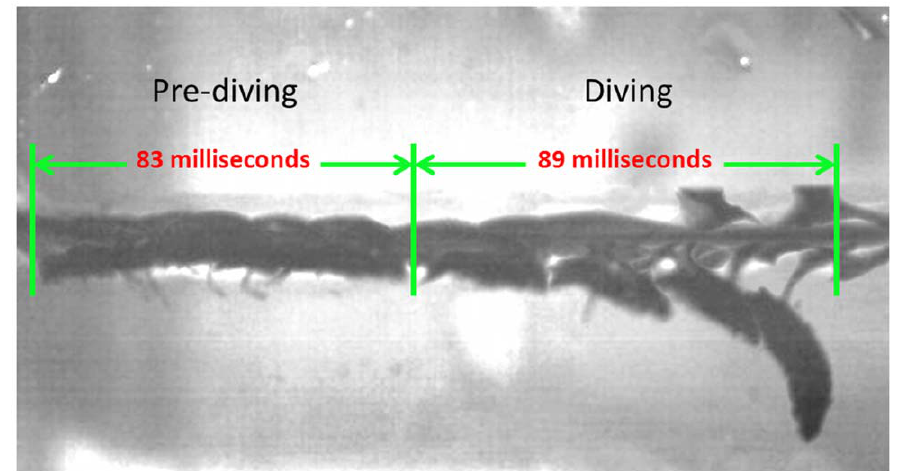
Figure 5. Time-lapse images of the diving process. This image shows the complete diving process, from the 83 ms pre-diving to the 89 ms diving process. To illustrate the diving motion, images captured every 17 ms are overlaid onto each other to show the complete diving